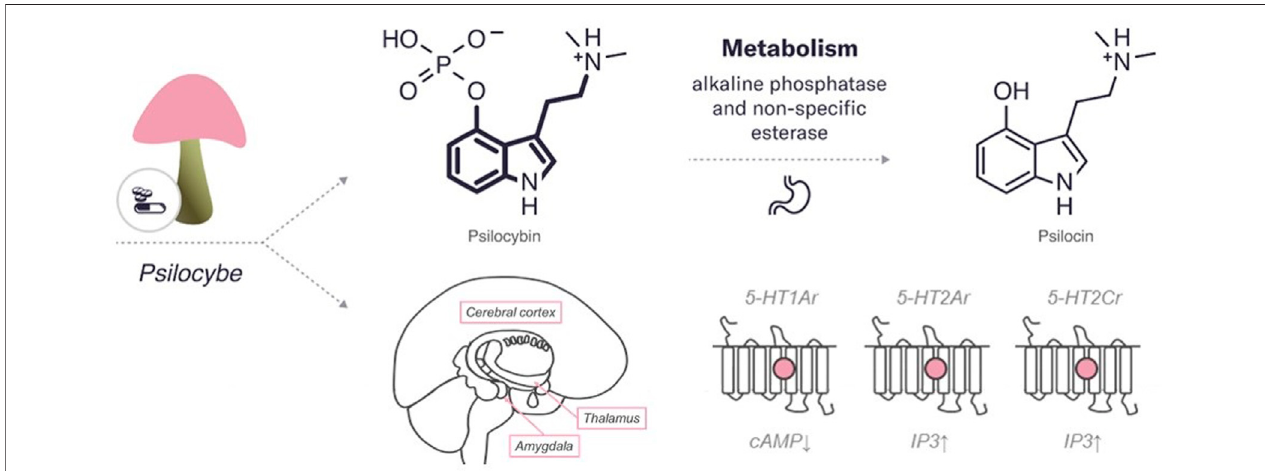
FIGURE 1 | An overview of the characteristics of psilocybin. The diagram includes the chemical structures of psilocybin and its metabolite. The bold lines indicate similarities in the chemical structure between this psychedelic and serotonin. In addition, the enzymes and major organs involved in the metabolism and excretion of psilocybin are indicated. The mechanism of action represents the targets of the psychedelic, both the region of the brain affected by the psychedelic and the receptors with which it interacts (pink circle for agonist). 5HT — serotonin receptors (2Ar, 1Ar, 2Cr, – subtypes). IP3, inositol-3-phosphate; cAMP, cyclic adenosine